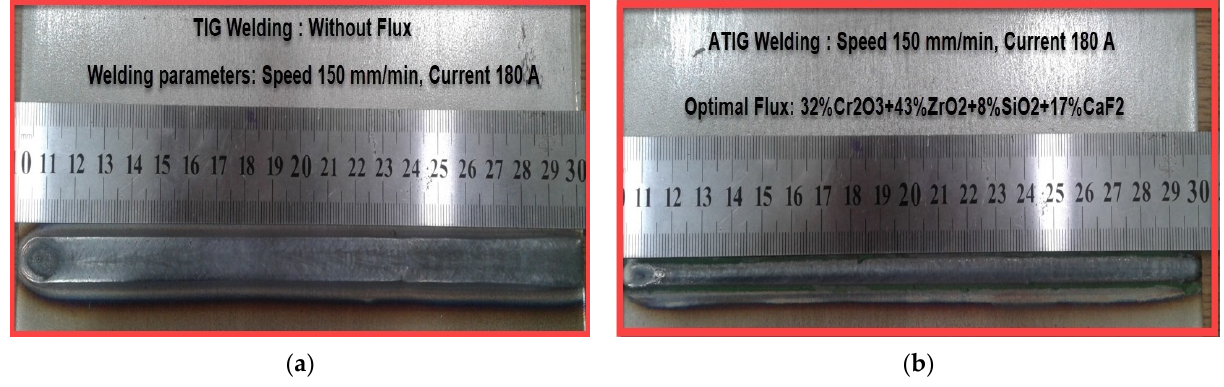
Figure 2. The external weld line appearance for TIG ( a ) and ATIG ( b ) weld lines. Pieces were cut from the welded plates for mechanical testing, weld morphology, and microstructure study according to the schematic drawing shown in Figure 3. The cutting machine used is Hydro-Jet Eco 0515 SL-Micro waterjet Cutting (KNUTH Germany).